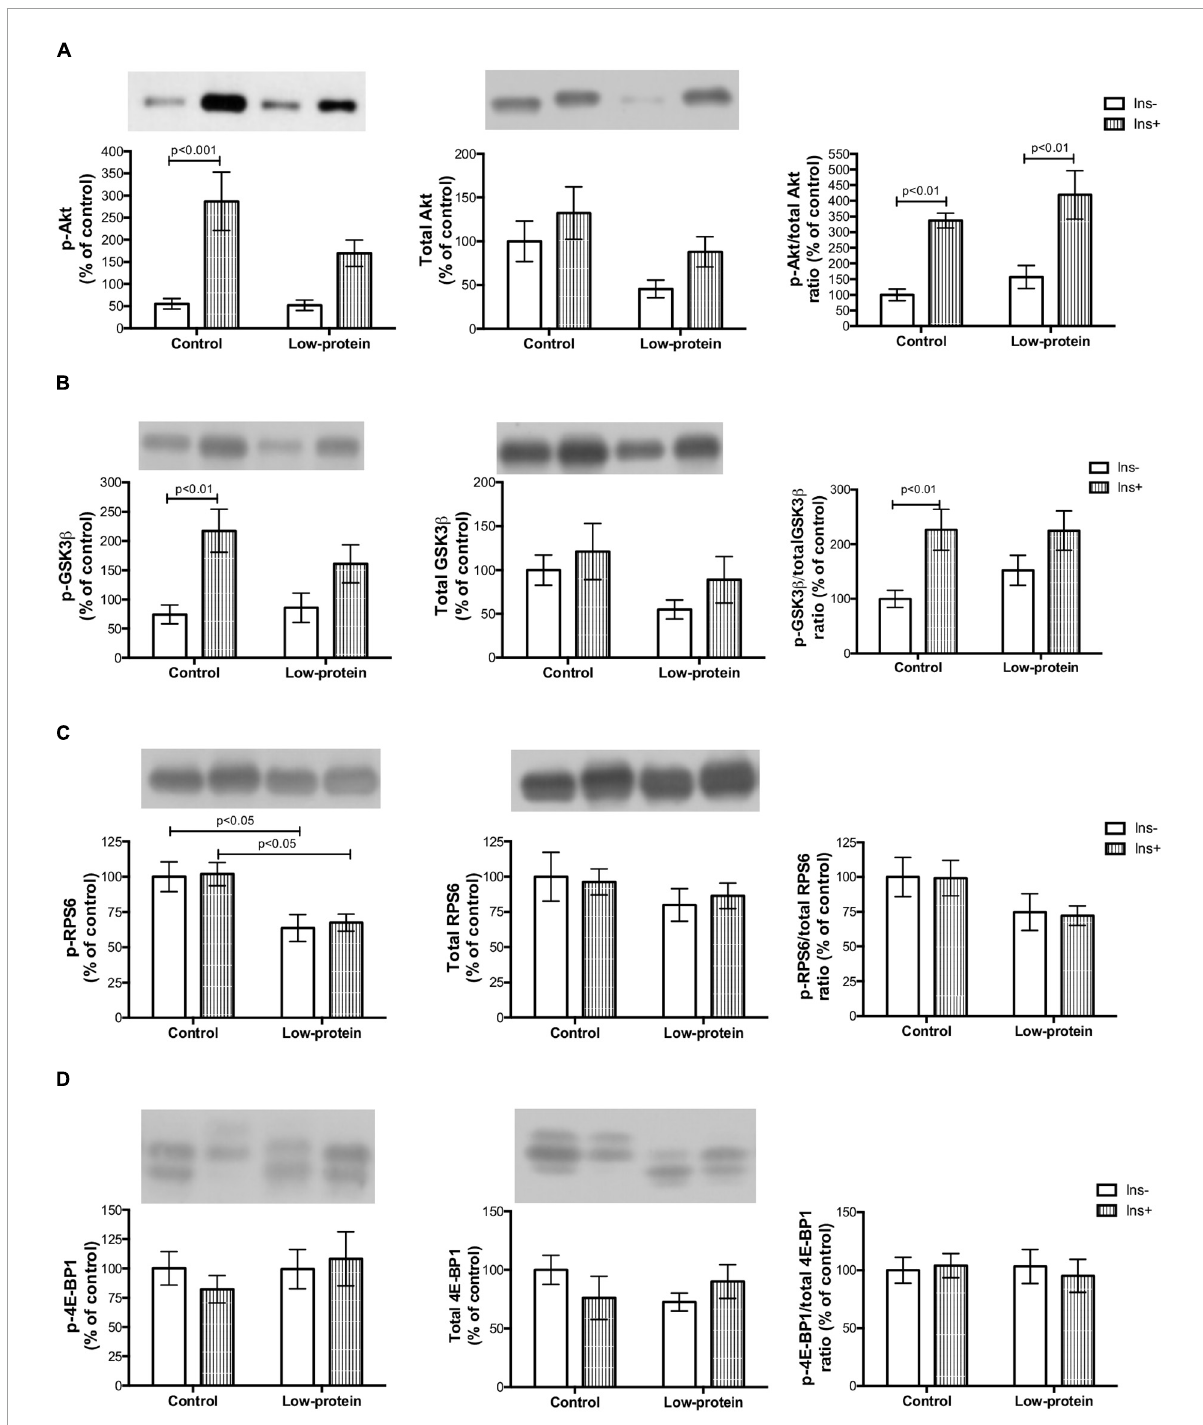
FIGURE5 Long-term effects of low-protein diet during early life on AKt-mTOR pathway signaling in soleus muscle isolated from adult rats. (A) Akt Ser473, total Akt and Akt Ser473/Akt ratio; (B) GSK3 β Ser9, total GSK3 β and GSK3 β Ser9/GSK3 β ratio; (C) RPS6 Ser240/244, total RPS6 and RPS6 Ser240/244/RPS6 ratio; and (D) 4E-BP1 Thr37/46, total 4E-BP1 and 4E-BP1 Thr37/46/4E-BP1 ratio in isolated soleus muscle, with or without insulin, in 7-month-old pups born to mothers fed a normoproteic (control, n = 5–6) or low-protein (LP, n = 5–6) diet during pregnancy and lactation. Results were analyzed using two-way ANOVA followed by Bonferroni post-test. In (A) , p < 0.05 (Maternal diet effect) for LP groups (without and with insulin) compared to the respective control groups using two-way ANOVA only (no statistical differences using the Bonferroni post-test). All values are expressed as mean ±